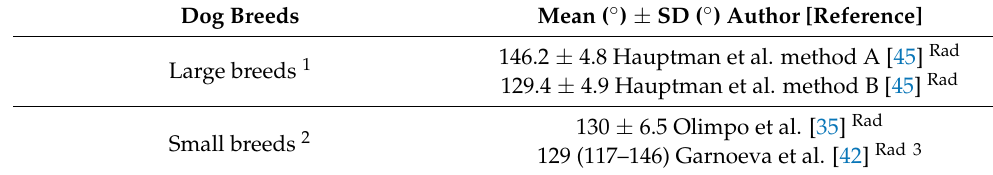
Table 4. Mean ± standard deviation of femoral inclination angle in healthy